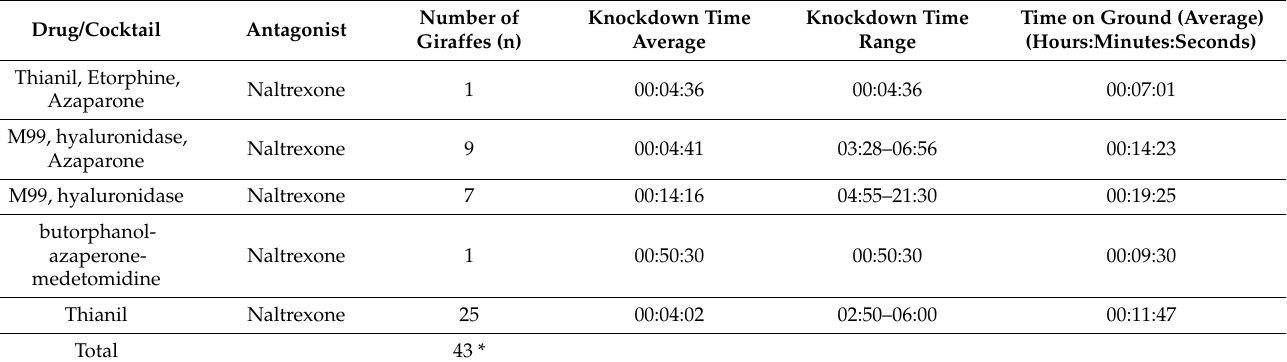
Table 2. Recorded data from drugs and drug cocktails used in the field during the present study on 43 occasions of giraffe